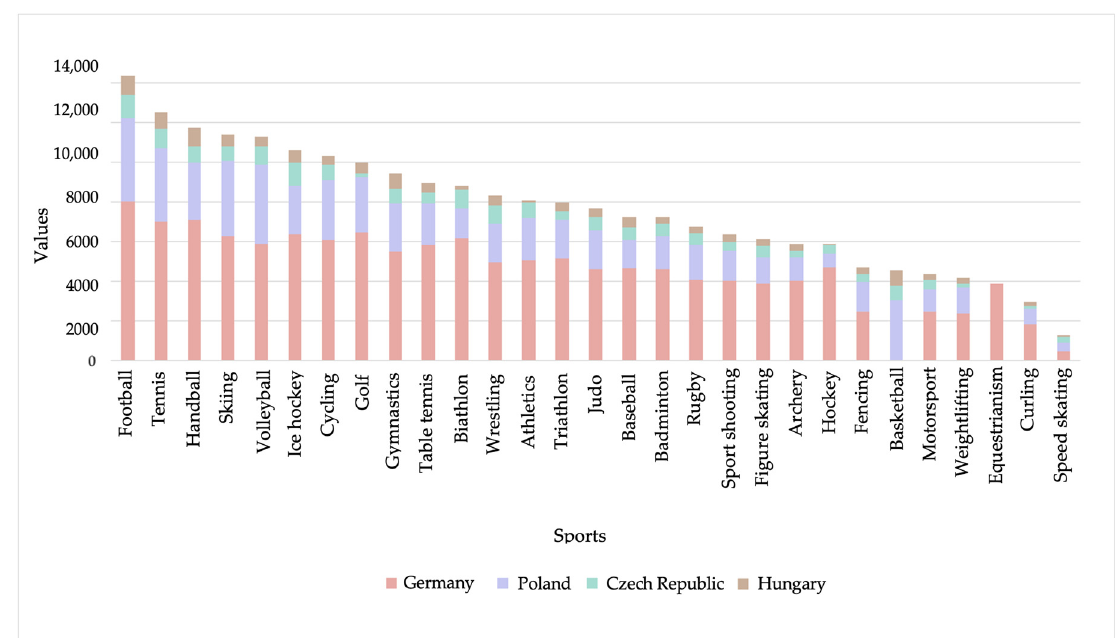
Figure 5. Final ranking of sports according to Google Trends searches; Source: Own elaboration based on the deliberate searches of keywords via Google Trends.